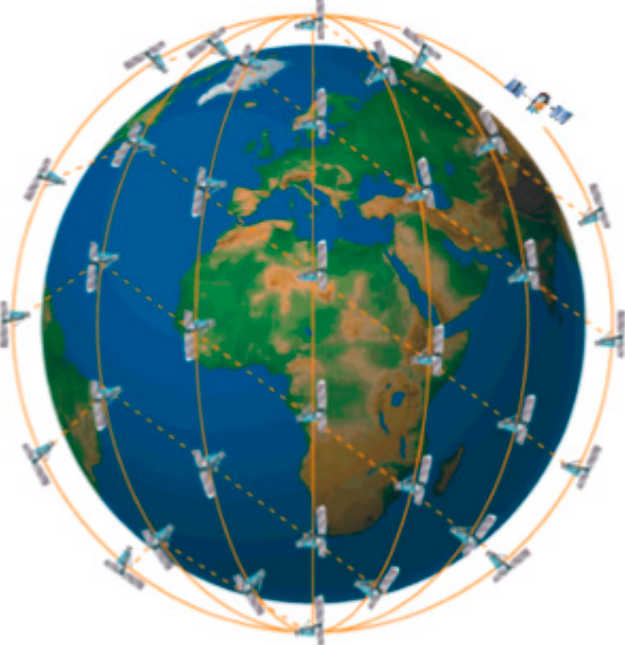
Figure 1. Proposed Constellation of CubeSats measuring Earth’s energy imbalance [9].